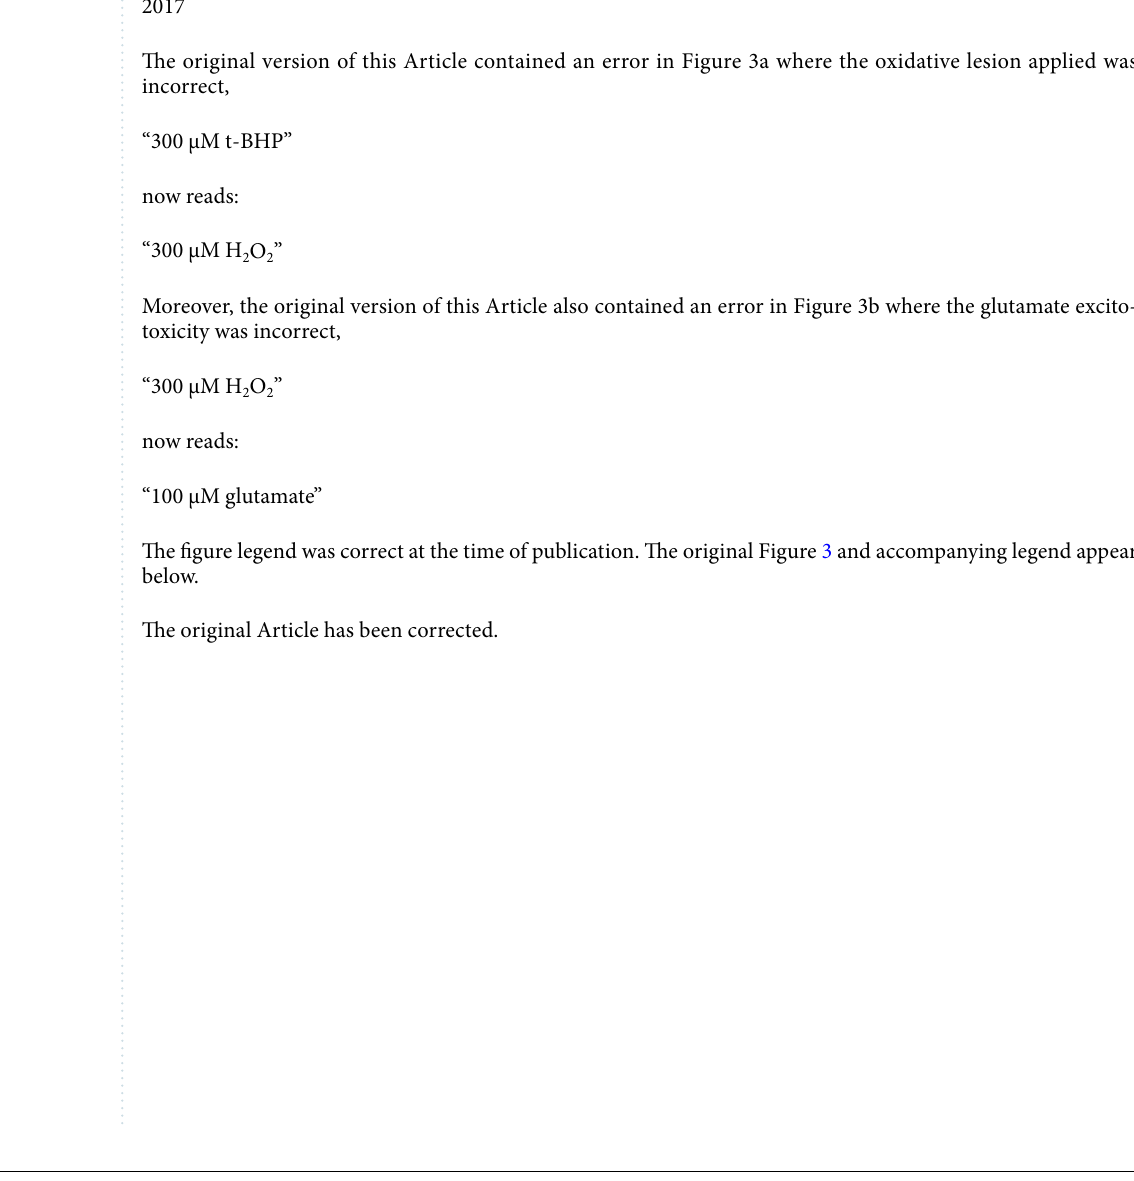
The figure legend was correct at the time of publication. The original Figure 3 and accompanying legend appear below. The original Article has been